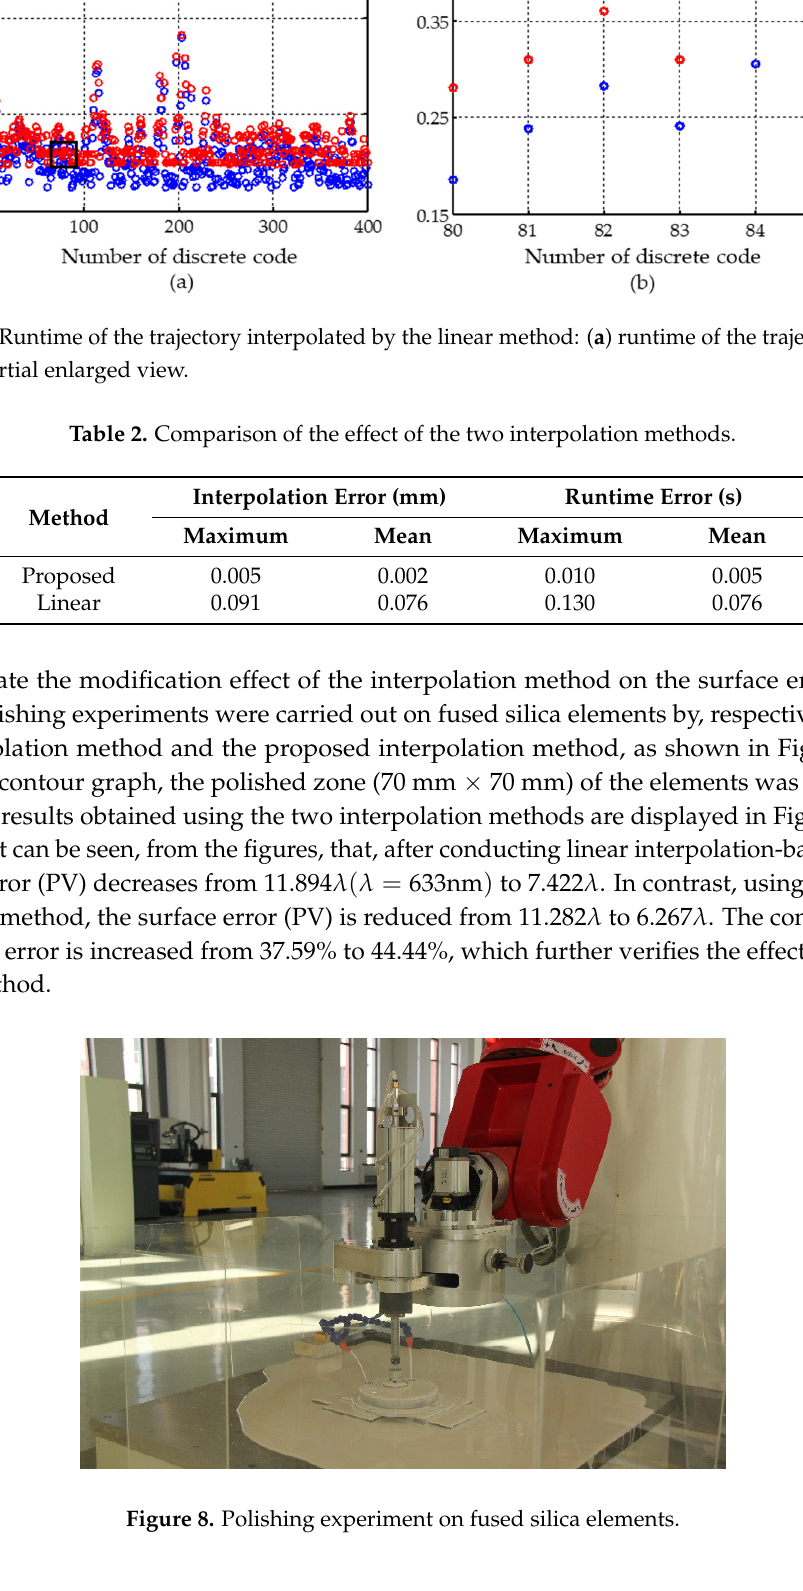
and ( b ) the partial enlarged view.